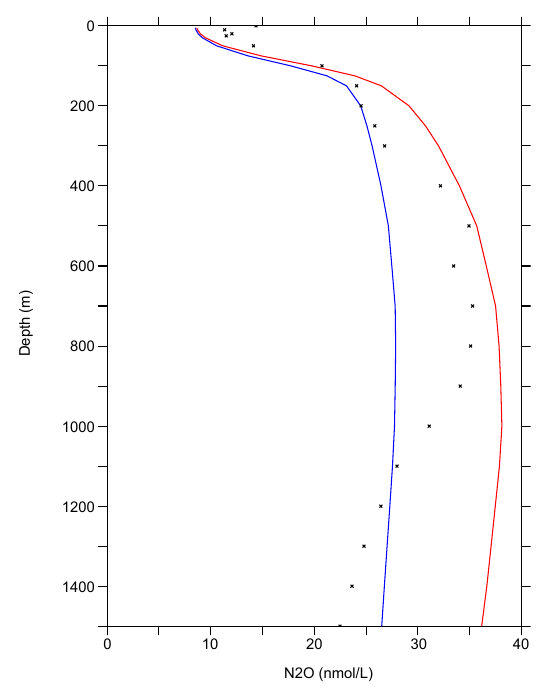
Figure 2. Global average depth profile of N 2 O concentration (in nmolL − 1 ) from the MEMENTO database (dots) (Bange et al., 2009). P.TEMP: blue; P.OMZ: red. Model parameterizations are av- eraged over the 1985 to 2005 time period from the historical simu-